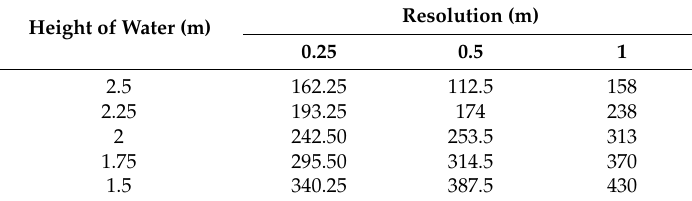
Table A4. Creek A Surface Area (m 2 ) from Terrestrial